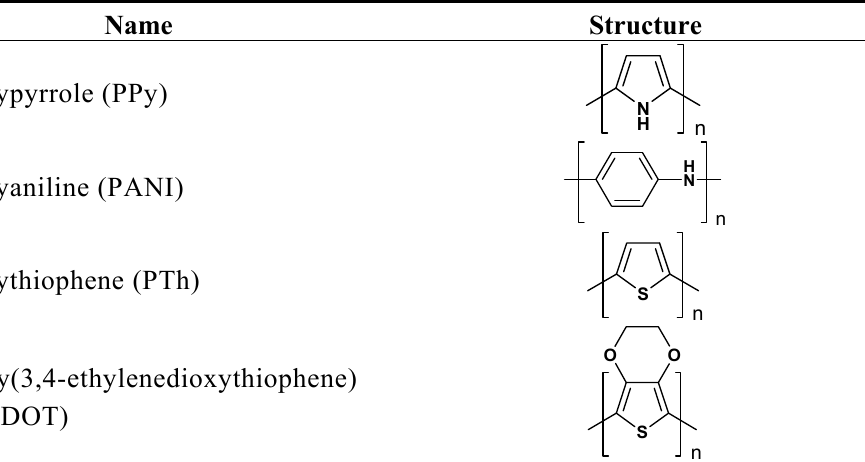
Table 1. Representative conducting